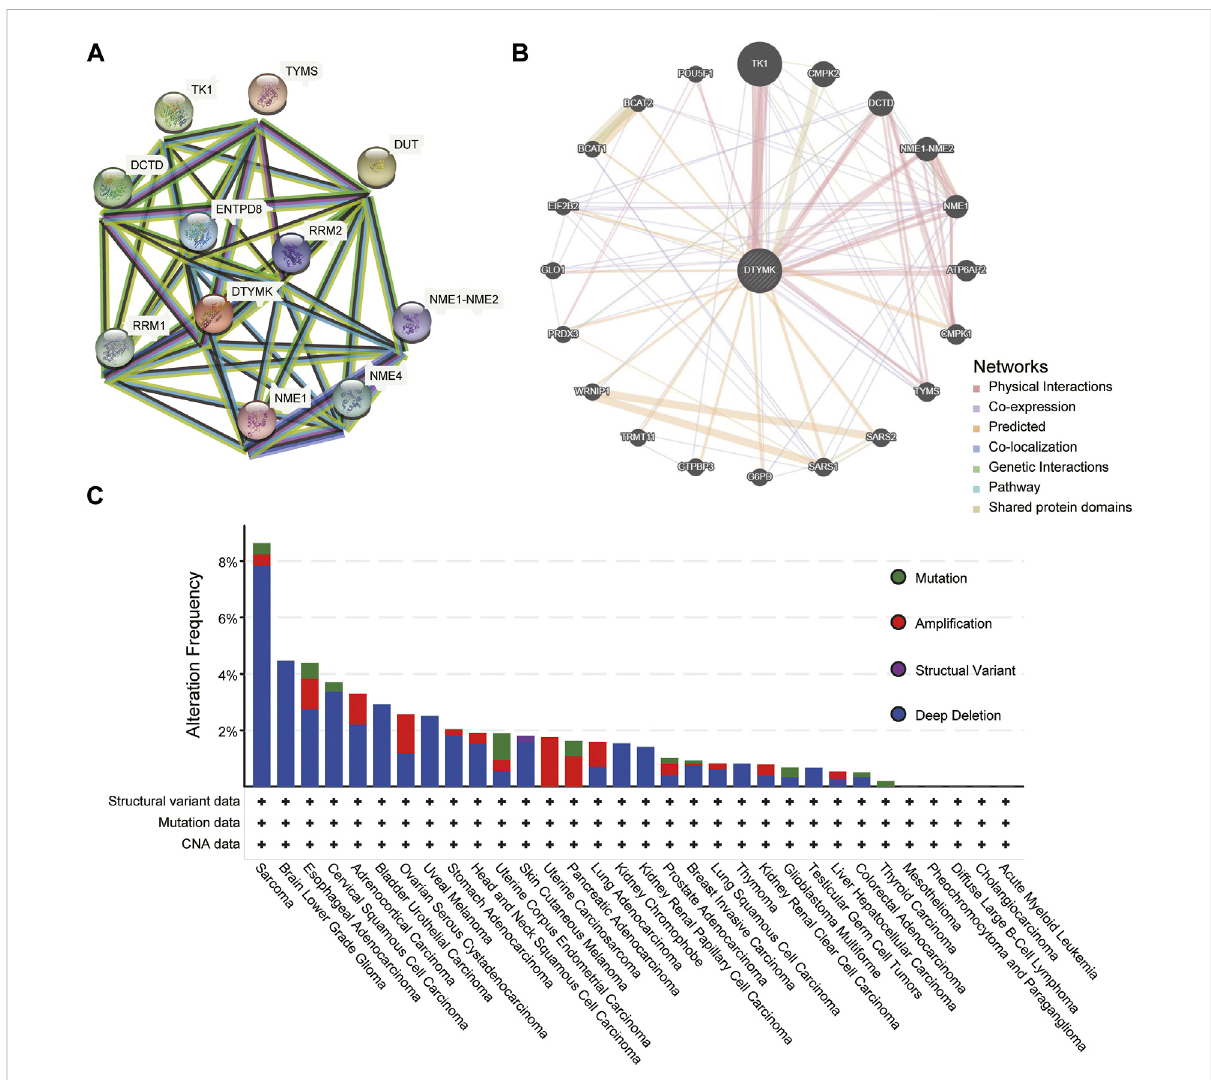
FIGURE 10 PPI network and genetic alteration characteristics. (A) A network of DTYMK and its co-expression genes. (B) GeneMANIA indicated DTYMK and itsco-expressiongeneswereinvolvedinpyrimidine – containingcompoundbiosynthetic processandpyrimidinenucleotidebiosynthetic/metabolic process. (C) The genetic alteration characteristics of DTYMK across different